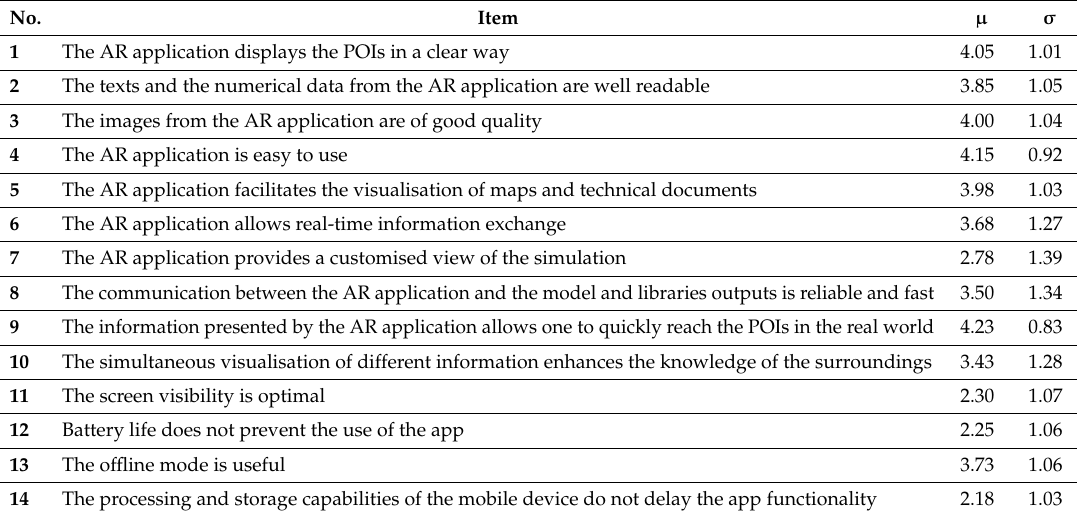
Table 3. Mean, µ , and standard deviation, σ , of the questionnaire